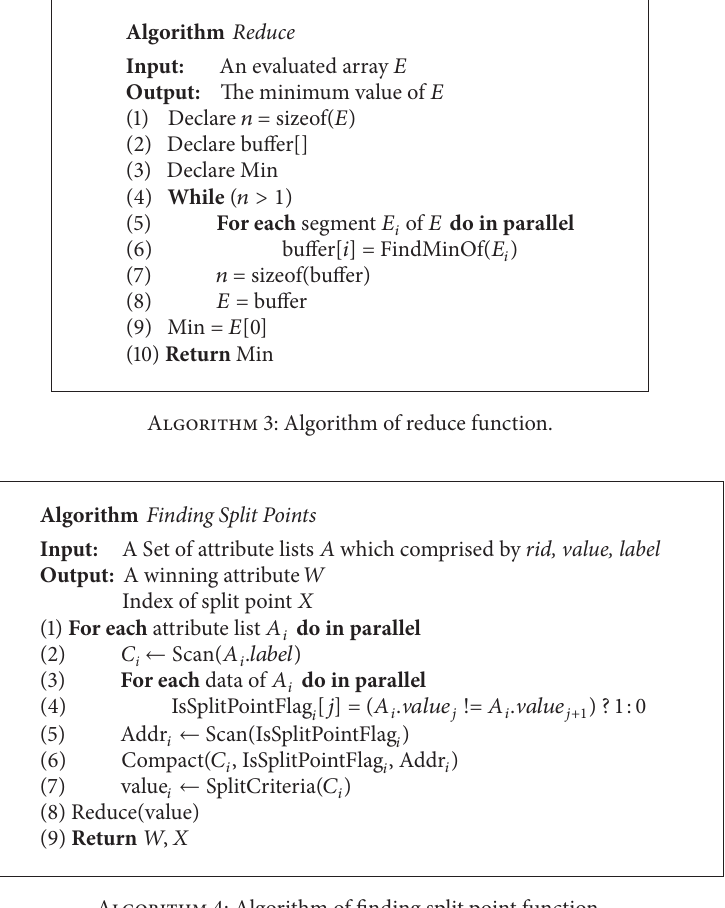
Algorithm 4: Algorithm of finding split point function.